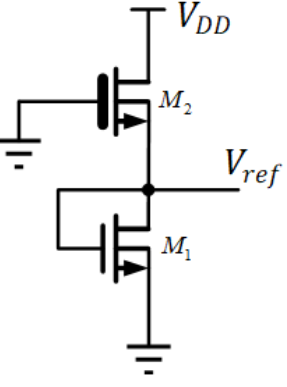
Figure 4. 2-Transistor Voltage Reference.